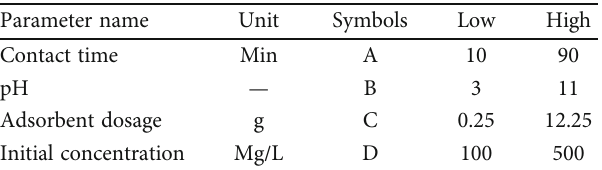
Figure 1: The structural formula for RR2. Table 1: Ranges and level of studied parameters in order to design the experiments.